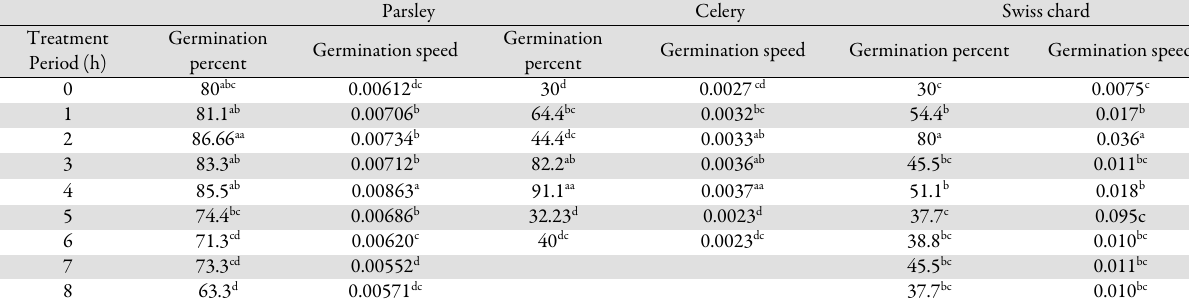
Table 1. Seed germination percent and speed